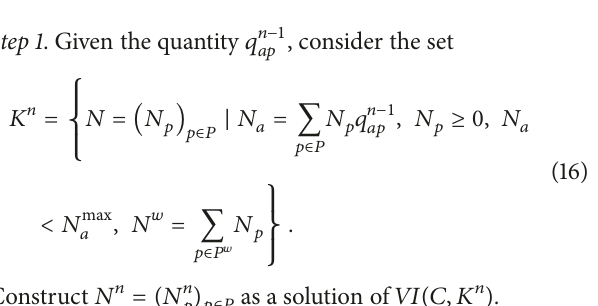
𝑛 ) by the follow-